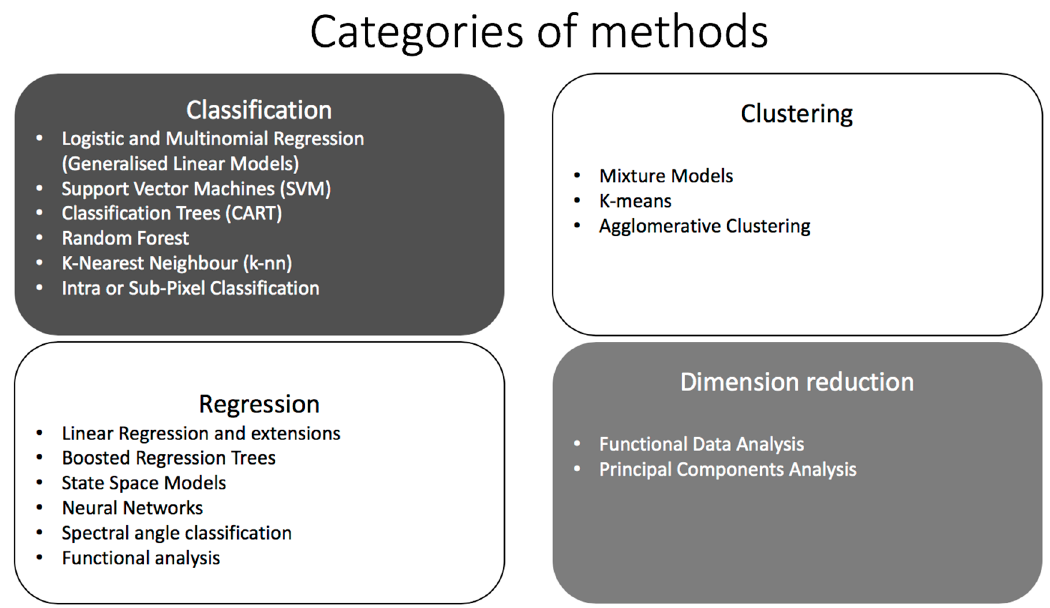
Figure 1. Statistical machine learning methods for analysis of remote sensing and other data, collated according to the analytic aim.